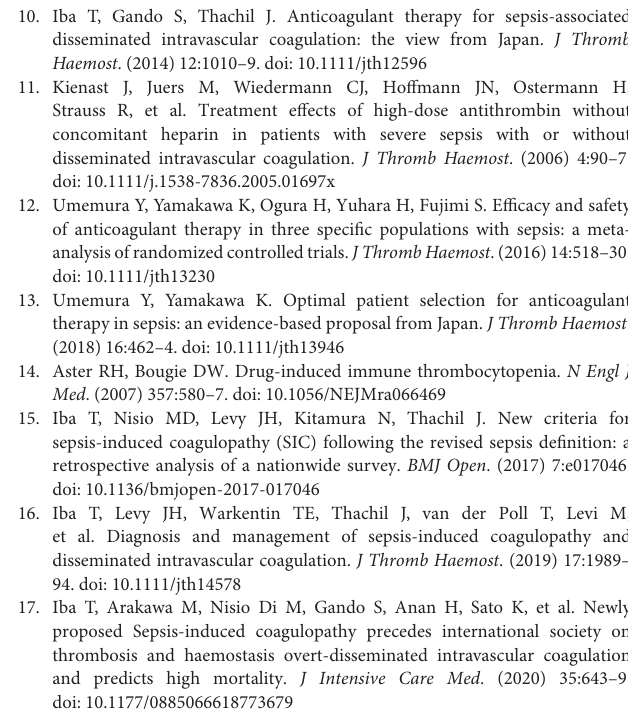
Supplementary Figure 1 | Model performance in different patient cohorts in MIMIC-IV. Supplementary Figure 2 | Model interpretation of the full model in eICU-CRD. Supplementary Figure 3 | Model interpretation of the compact model in eICU-CRD. Supplementary Table 1 | Sepsis-induced coagulopathy (SIC) criteria. Supplementary Table 2 | Predictors extracted in MIMIC-IV and eICU-CRD. Supplementary Table 3 | Baseline characteristics between the SIC and non-SIC groups in the MIMIC-IV cohort. Supplementary Table 4 | Hyperparameter search domain in Bayesian optimization and final settings. Supplementary Table 5 | Results of logistic